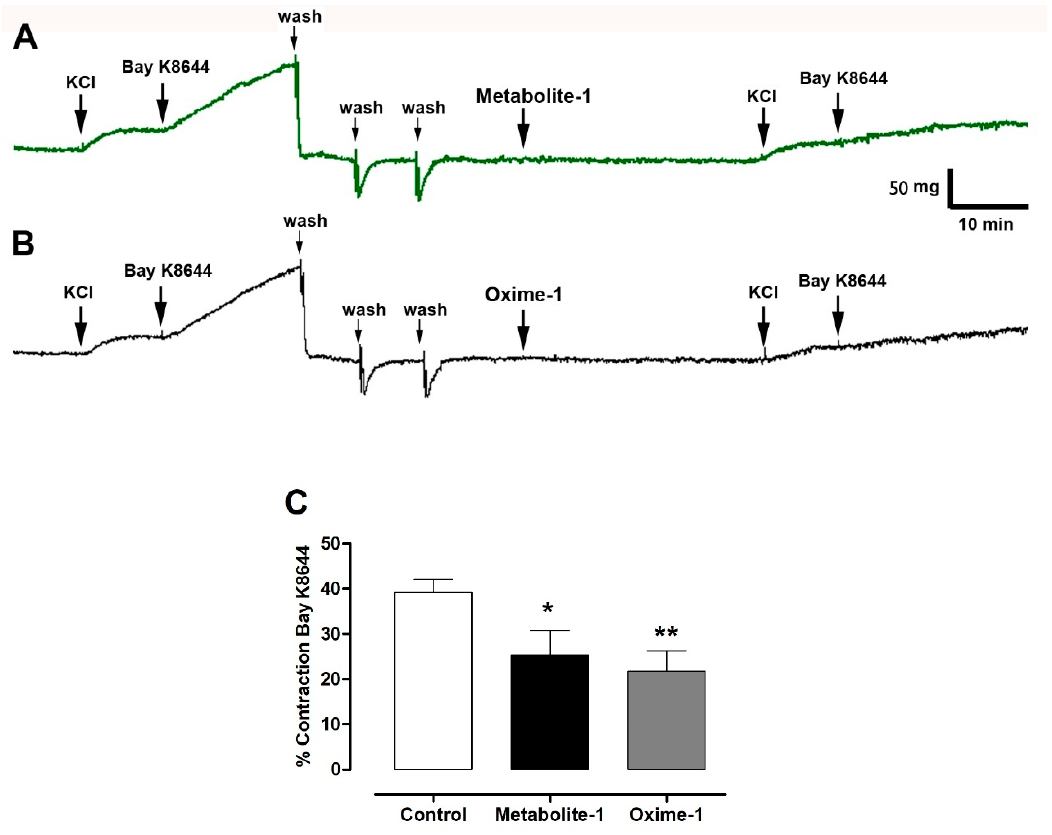
Figure 9. Metabolite–1 and oxime–1 decreases contractile response to Bay K8644 in normal Ca 2+ buffer. Intact aortic rings were contracted with 10 mM KCl, and 10 nM Bay K8644 in the presence of 10 − 5 M metabolite–1 ( A ) or 10 − 5 M oxime–1 ( B ) for 20 min. Data are presented as the average standard error of the mean (SEM) of 4 independent experiments ( C ). * p < 0.05, ** p <0.01 versus control (without bioactive molecules).